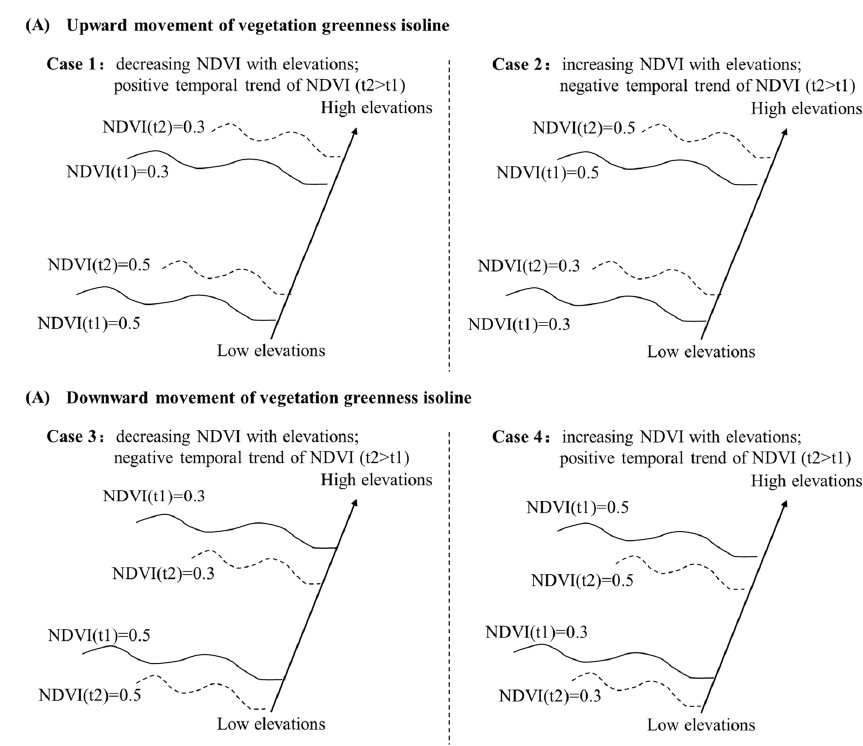
Figure 3. A sketch showing the concept of elevational movement of greenness isoline. t 2 indicates a time later than the time t1 (i.e., t 2 > t 1 ). For the detailed explanations for the panels, please refer to the text.